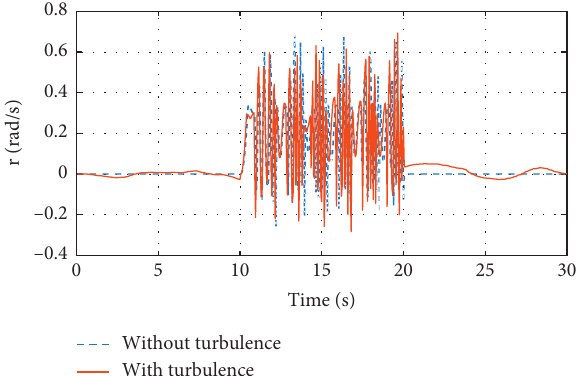
Figure 12: The difference of heading angle rate with the time.